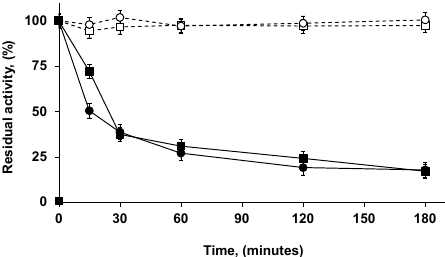
Figure 9. Inactivation courses of some co-immobilized biocatalysts at pH 7.0 and 60 °C. Dotted line, empty squares: octyl-VS-CALA-TLL-CALB-PEI; dotted line, empty circles: octyl-VS-CALB-TLL-CALA-PEI; solid line, solid squares: octyl-VS-PEI-RML-LEU and solid line, solid circles: octyl-VS-PEI-LEU-RML. Other specifications are described in Methods.